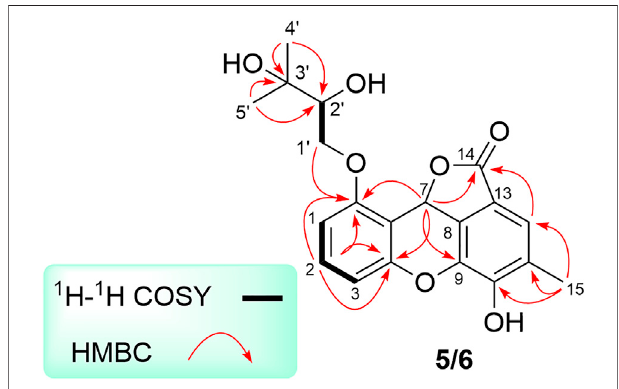
FIGURE 5 | Key 1 H- 1 H COSY, and HMBC correlations of 5 and 6 .